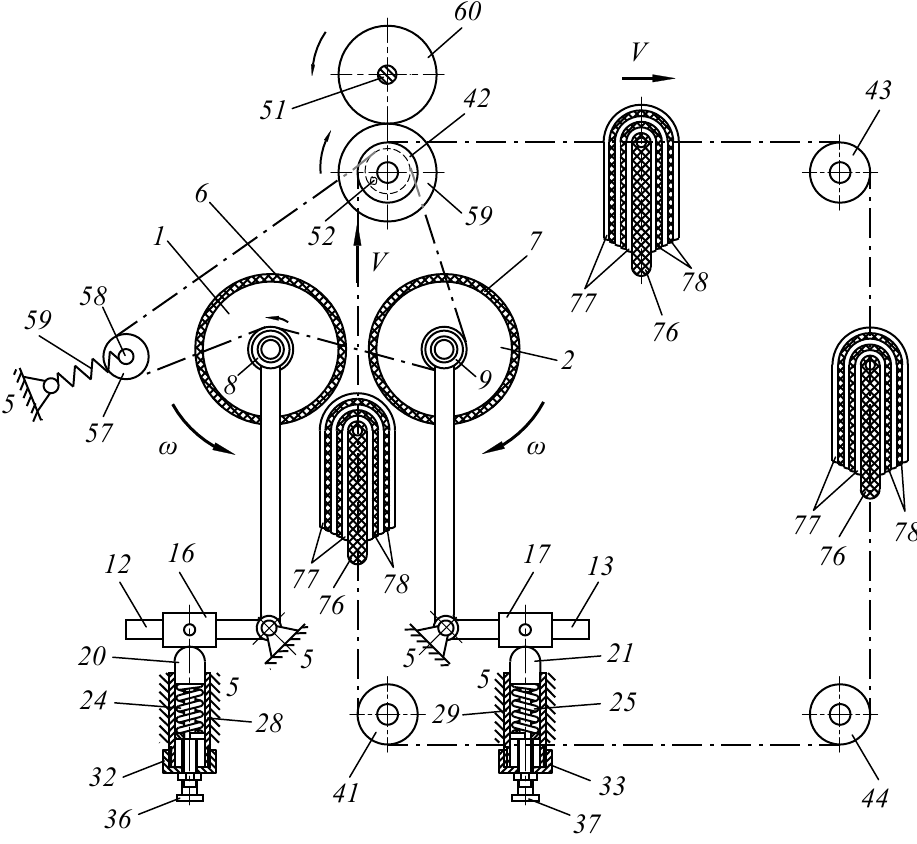
Figure 1. Scheme of a roller squeezing machine.